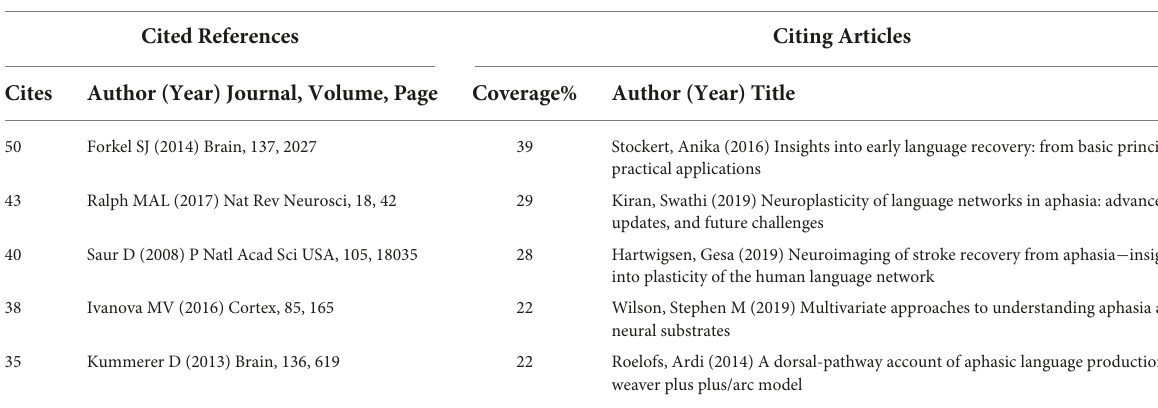
TABLE 5 Cited references and citing articles of Cluster #1 on functional magnetic resonance imaging (fMRI)